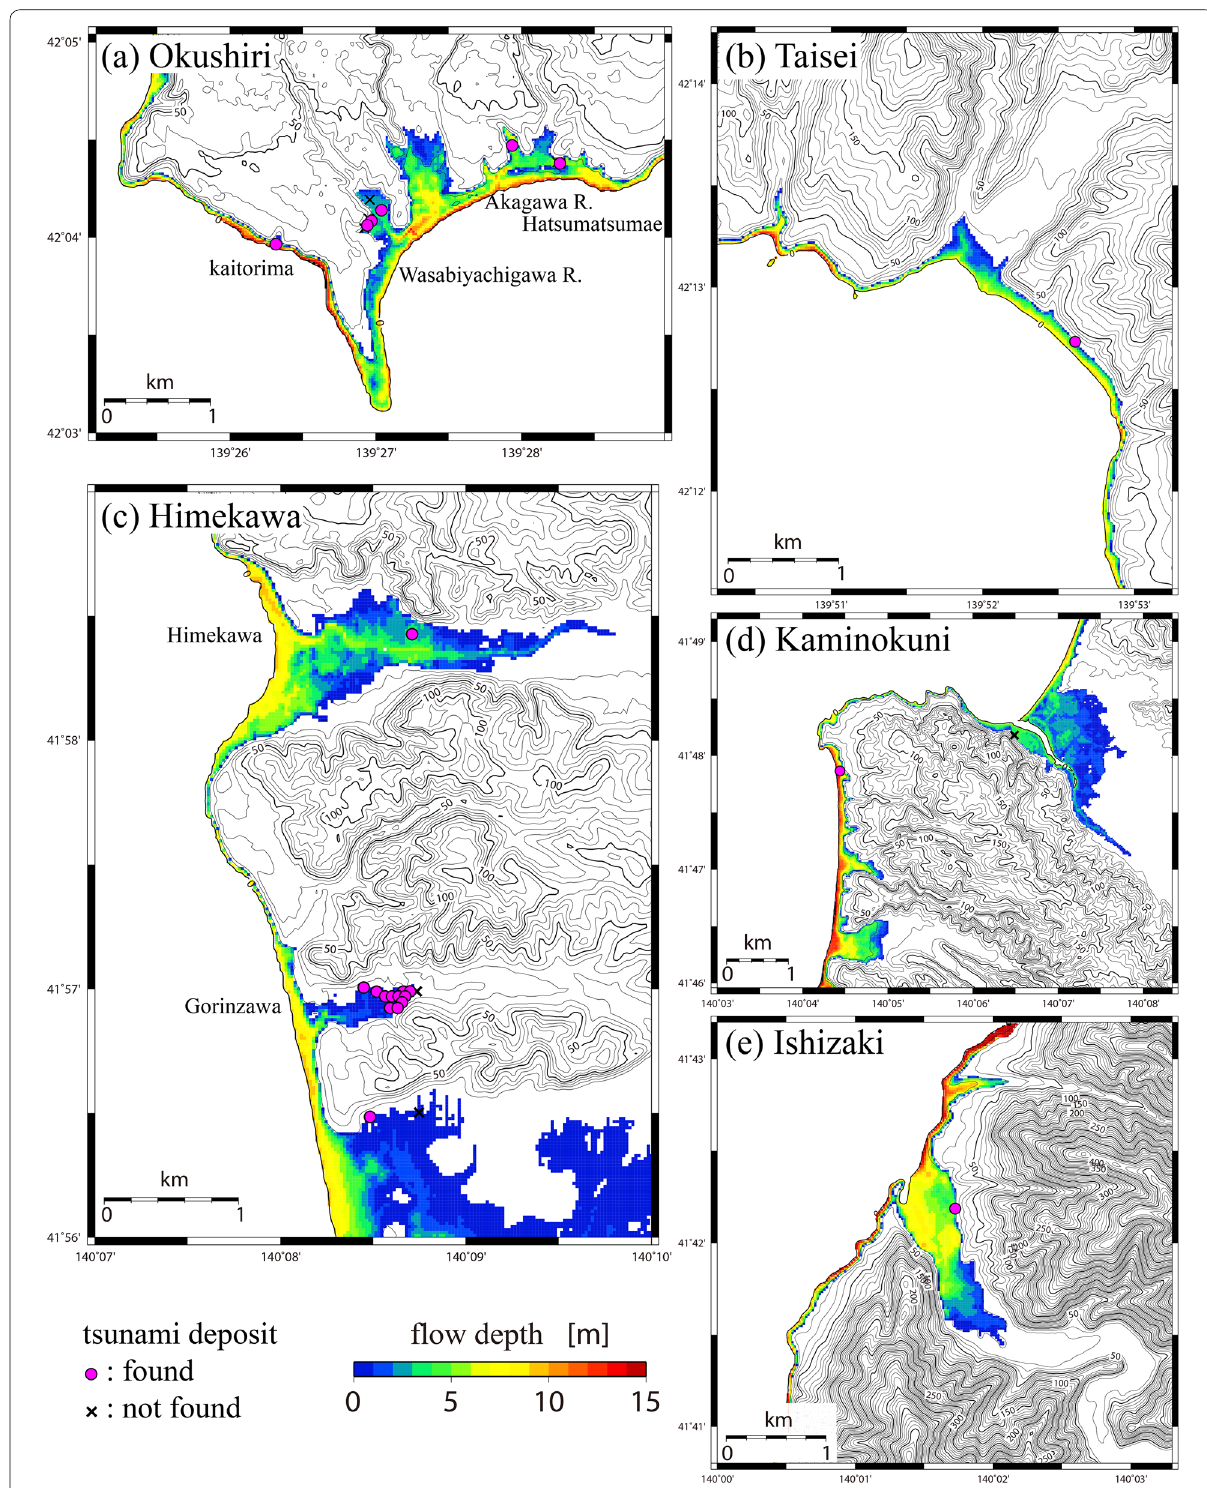
Fig. 3 Computed tsunami inundation area: a Kaitorima, Wasabiyachigawa, Akagawa, and Hatsumatsumae on Okushiri Island; b Taisei in Setana town; c Himekawa in Otobe town; d Kaminokuni; and e Ishizaki in Kaminokuni town. Tsunami deposit distributions are shown in pink circles. The elevation contour interval is 10